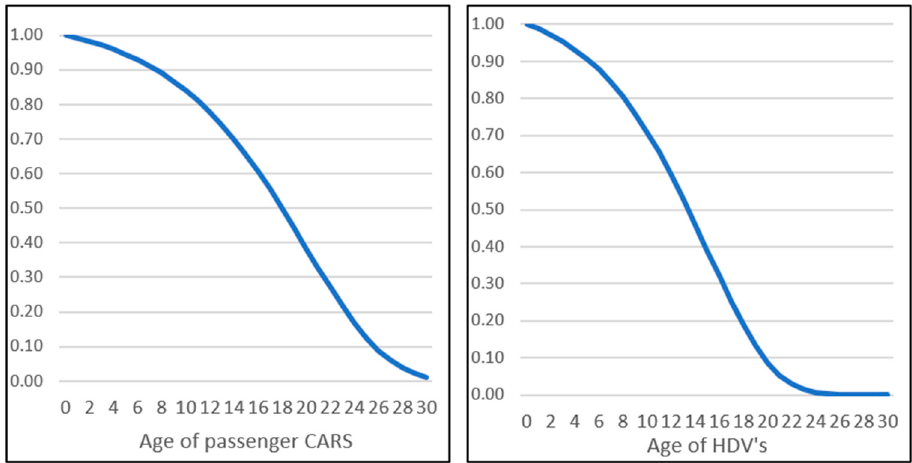
Figure 4. Survival rates for passenger and freight transport (depending on the age of vehicles). Source: own calculations based on TR 3 E model results.